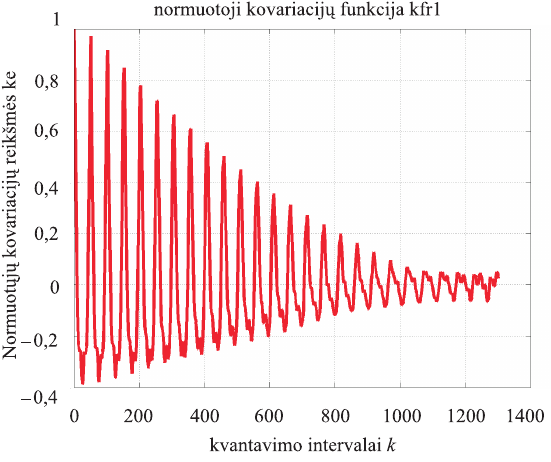
Fig. 4. Graphical view of the normalised auto-covariance function of the fragment of the magnetic resonance view of the healthy human brains by moving quantation